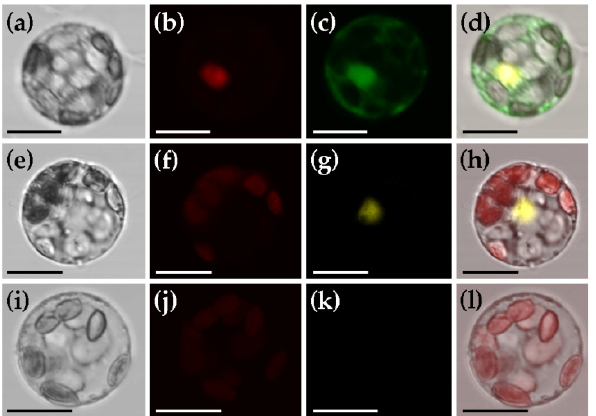
Figure 6. Subcellular protein localization and protein-protein interaction analyses using the transient gene expression system of C. pumila mesophyll protoplasts. ( a – d ) Subcellular protein localization. ( a ) Bright field image of mesophyll protoplast; ( b ) m-Cherry fluorescence detected in nucleus; ( c ) GFP fluorescence localized in both nucleus and cytoplasm; ( d ) Merged image. ( e – l ) Protein-protein interaction analyses between TDR1 and bHLH142. ( e – h ) Experimental group co-transfected with TDR1-YFP N and bHLH142-YFP C ; ( i–l ) Control group co-transfected with TDR1-YFP N and YFP C . ( e , i ) Bright field image of mesophyll protoplast; ( f , j ) Chloroplast autofluorescence image; ( g , k ) YFP fluorescence image indicating the interaction between TDR1 and bHLH142; ( h , l ) Merged image. Scale bars: 20 μ m.